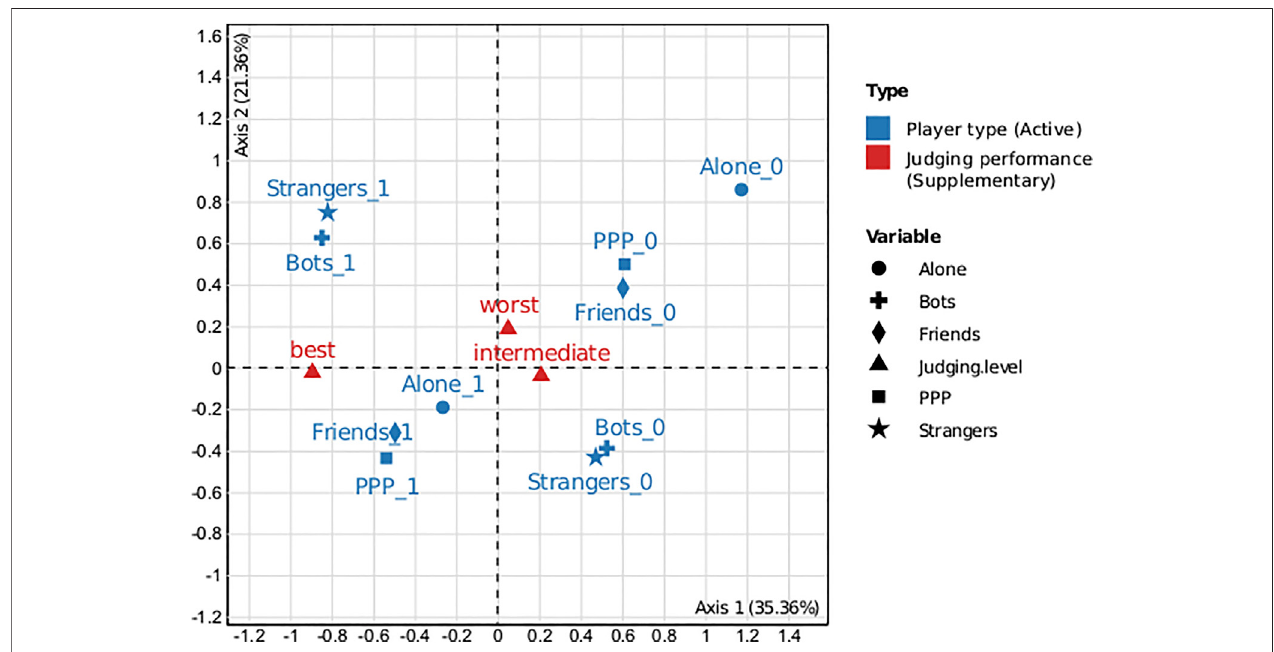
FIGURE 8 | Multiple correspondence analysis plot for dimensions 1 and